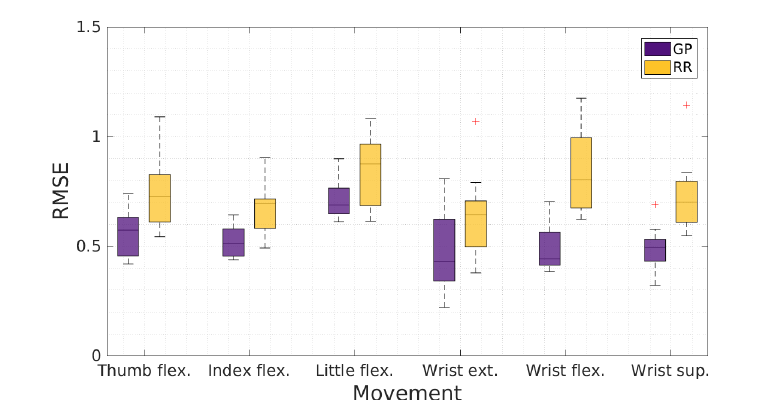
Figure 8. Comparison of the root-mean-square error (RMSE) between Gaussian process regression (GPR) and ridge regression (RR) for the different movements executed by the